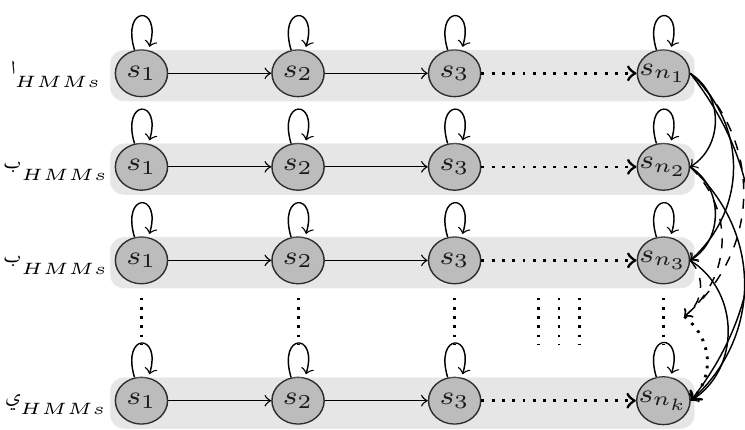
Figure 5. A plain structure of the HMM threshold